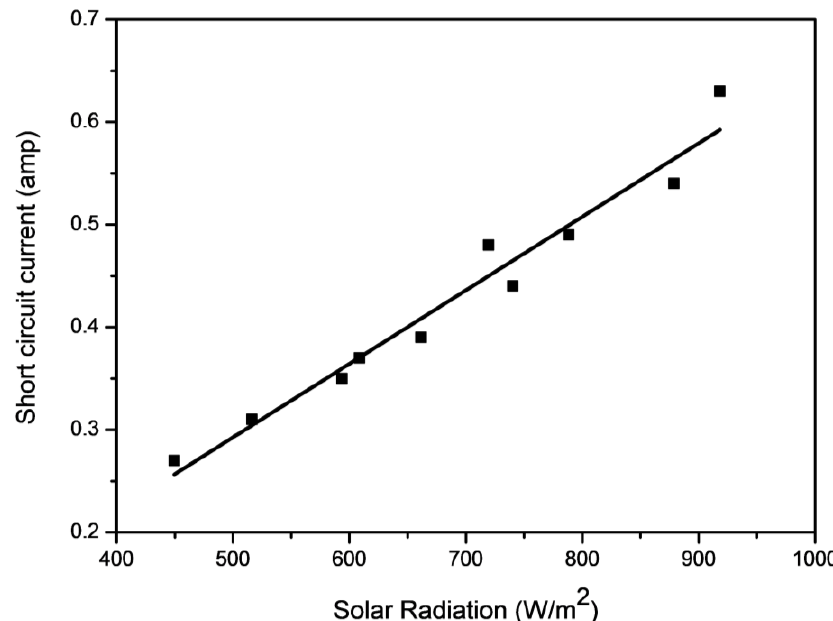
Figure 8. Output current with solar irradiance.